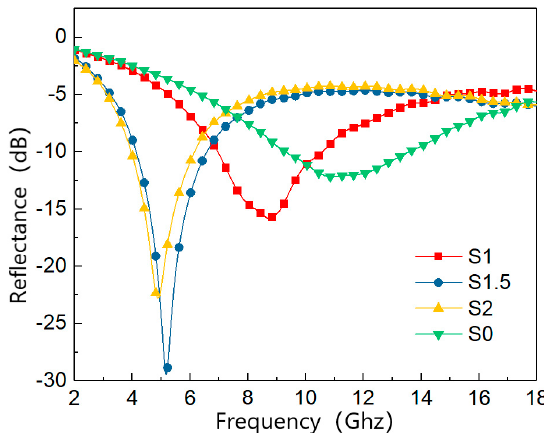
Figure 3. The RL of four samples with 3 mm thickness.